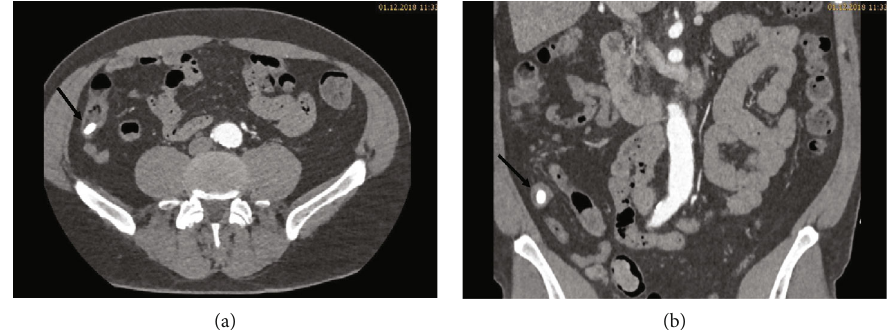
Figure 3: (a, b) Transversal and coronal slides of the abdominal CT in the arterial phase: a sharply demarcated structure in the small bowel is